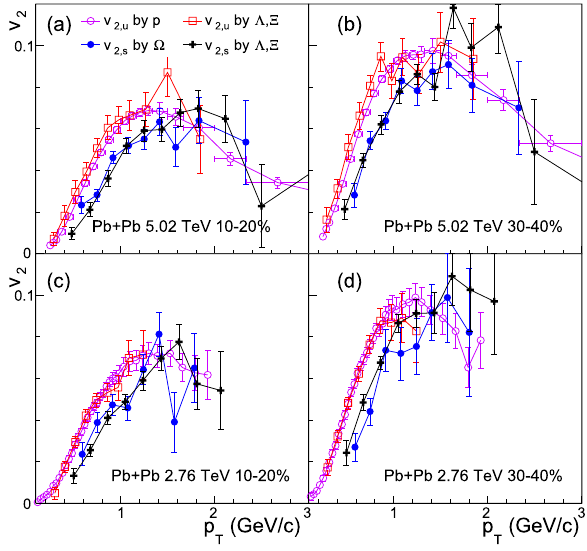
Fig. 3 v 2 , u ( p T ) and v 2 , s ( p T ) extracted from experimental data for v 2 ofidentifiedhadronsatmidrapidityinPb+PbcollisionsatLHCenergies